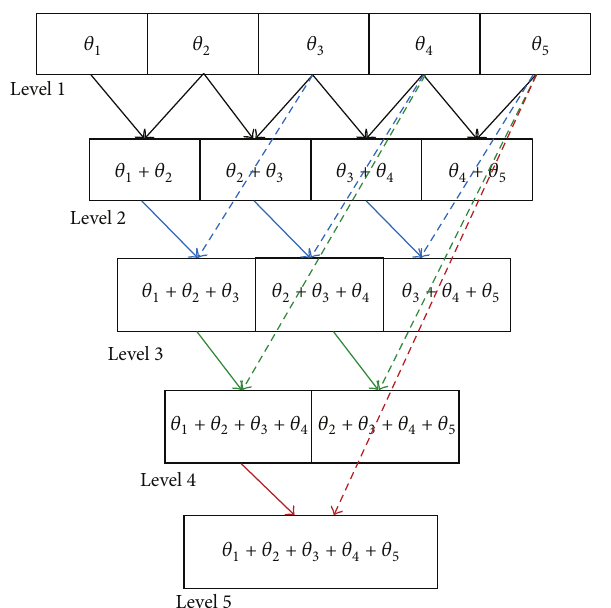
Figure 3: Example triangle structure used to determine the total power in all subband combinations. This structure is a variation of Pascal’s